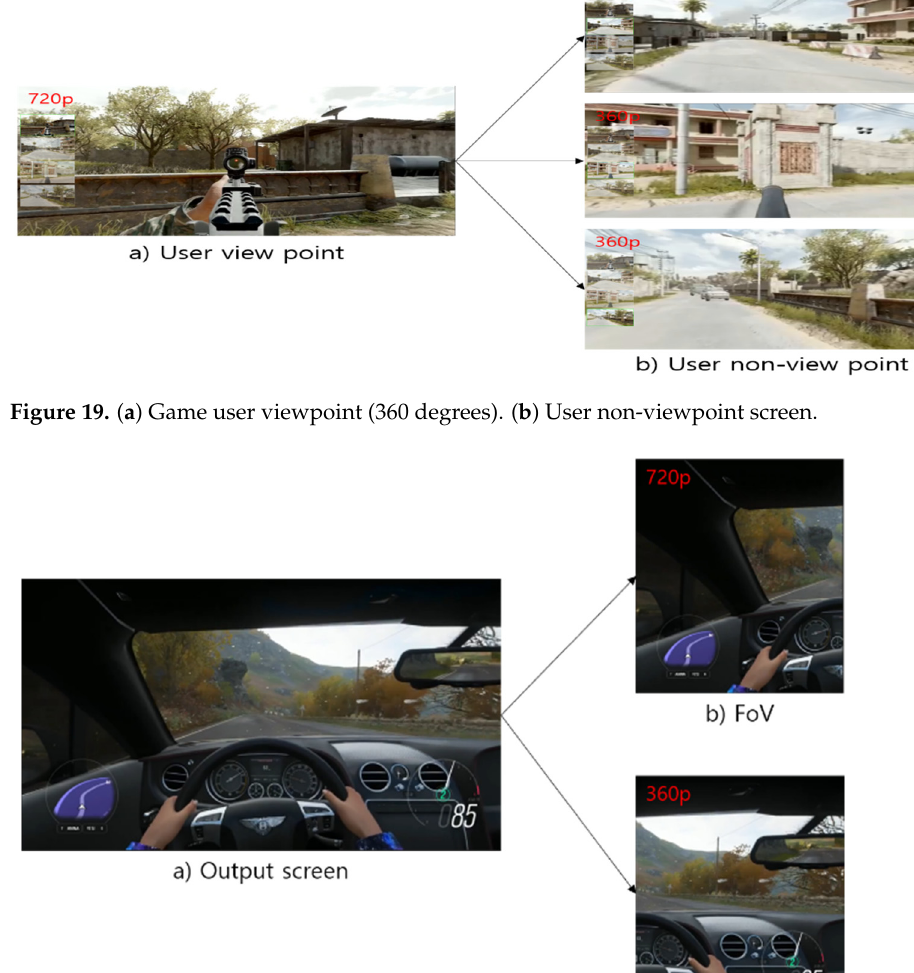
Figure 20. ( a ) 2D game split into ( b ) FoV and ( c ) non-FoV.